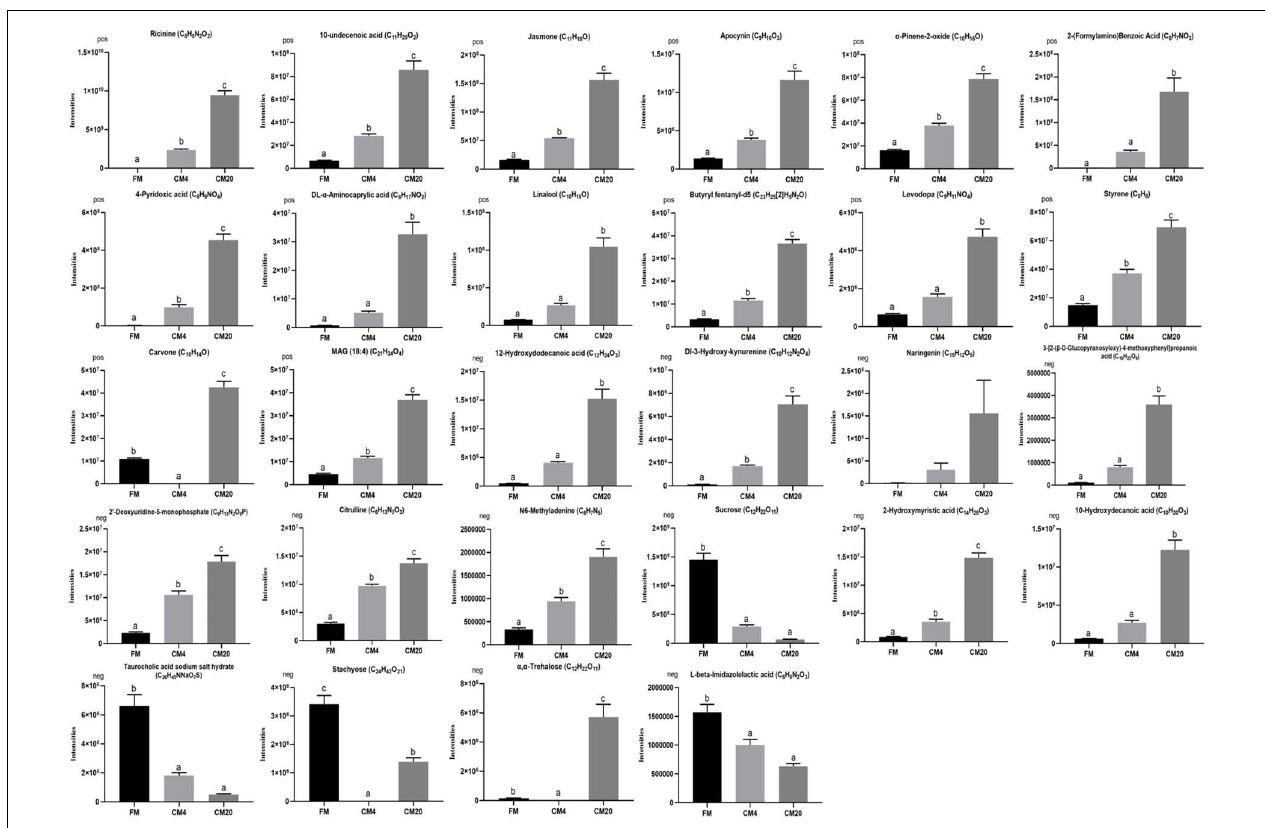
FIGURE 10 | Intensities of the metabolites identified in the positive and negative modes. Data represented the mean ± SE (Turkey’s HSD, P < 0.05; n = 6). Vertical bars marked with no letters do not differ significantly ( P > 0.05) among groups. In the bar plots, FM, fishmeal; CM4, 4% replacement of fishmeal with castor meal; and CM20, 20% replacement of fishmeal with castor